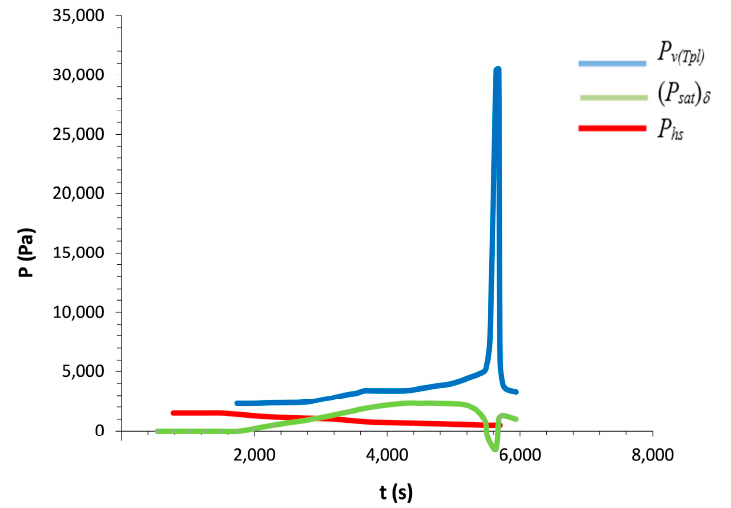
Figure 15. Comparison of vapor pressure corresponding to the surface temperature of the plate in contact with the porous medium, P v ( T pl ), with the pressure at temperature at the interface, ( P sat ), and the hydrostatic pressure, P hs , in the S+DS porous medium.